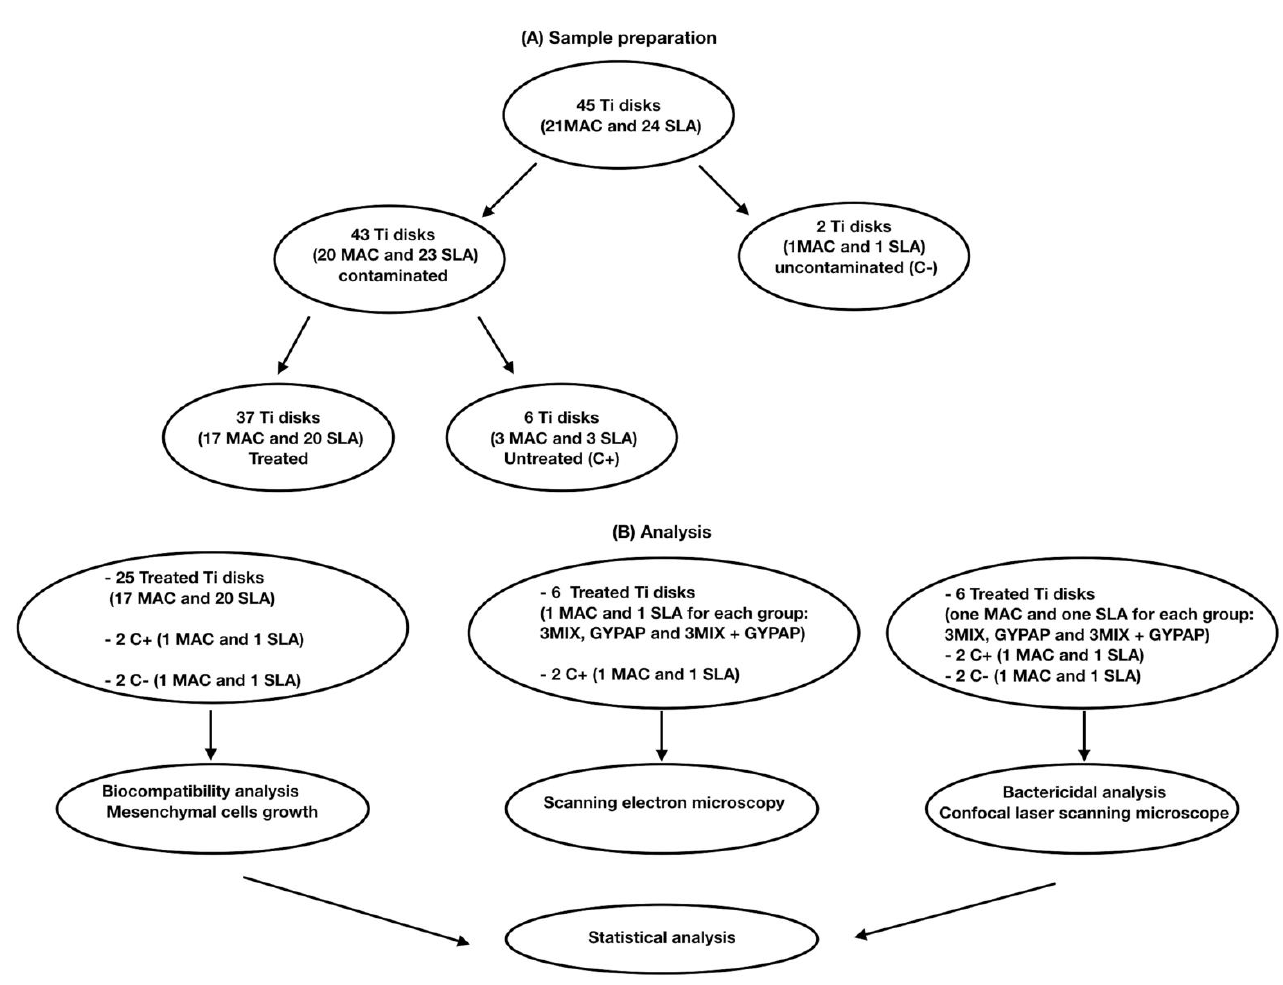
Figure 1. Flowchart of the study. ( A ) Sample preparation. ( B ) Analysis.